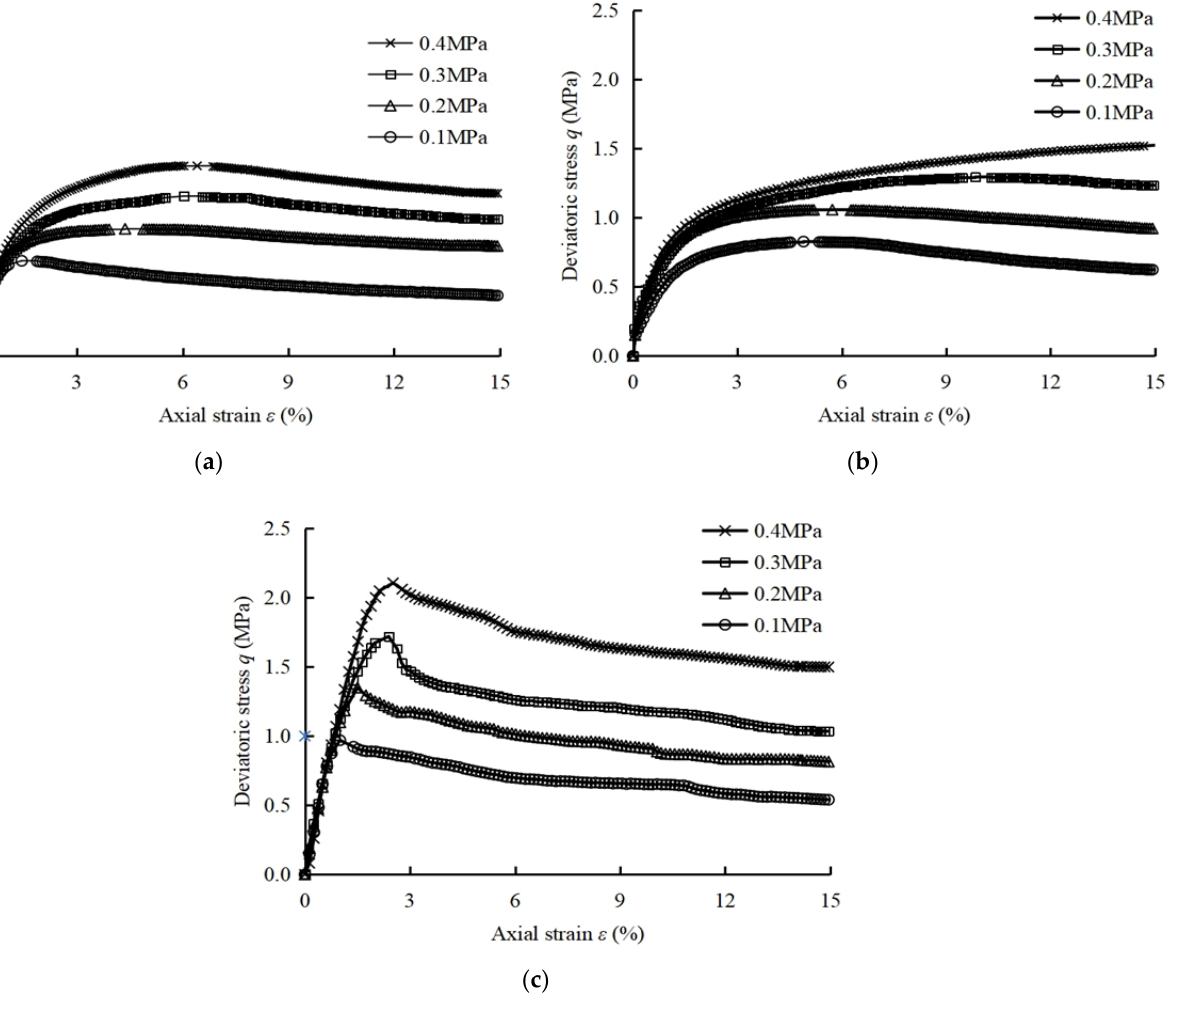
Figure 2. Stress-strain curves. ( a ) LS sample; ( b ) PLS sample; ( c ) FLS sample. Table 4. Mechanical parameters of modified